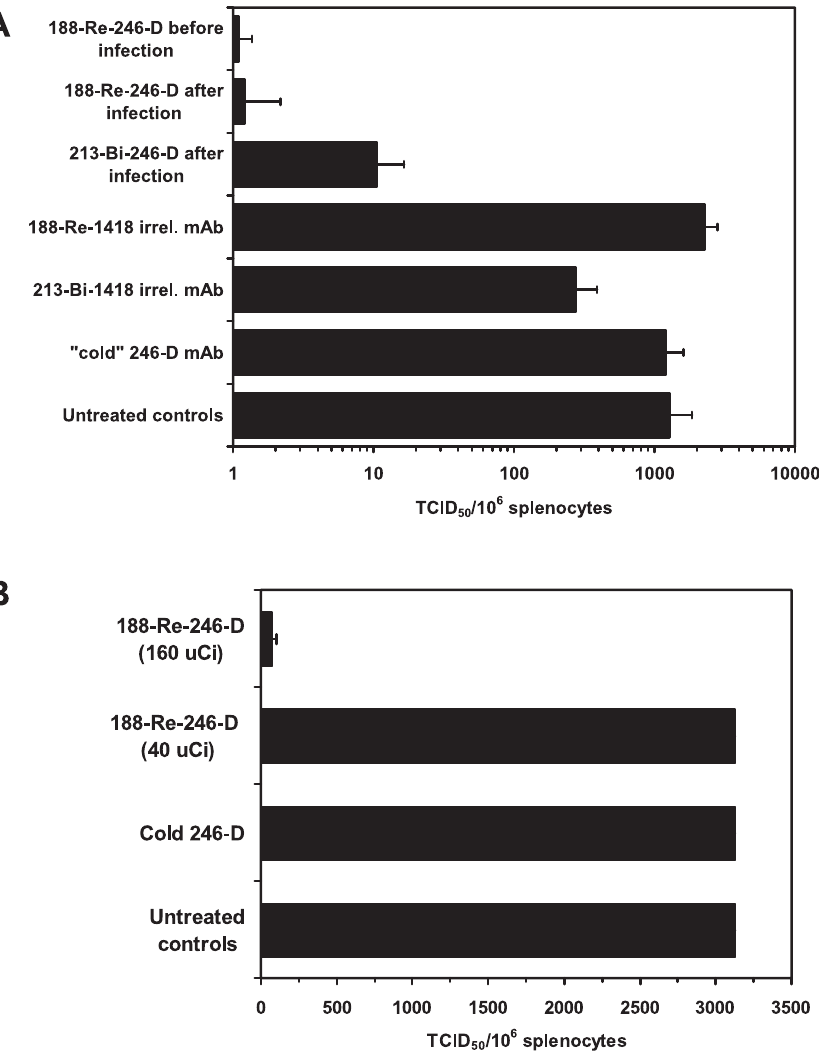
Figure 3. RIT of SCID Mice Injected Intrasplenically with HIV-1 JR-CSF -Infected Human PBMCs with 188 Re- and 213 Bi-Labeled Human Anti-gp41 mAb 246-D (A) Mice were treated IP 1 h after infection with infected hPBMCs with either 20 l g of cold 246-D ( n ¼ 4); 100 l Ci (3.7 MBq) (20 l g) of 213 Bi-1418 ( n ¼ 5) or 80 l Ci (2.96 MBq) (20 l g) of 188 Re-1418 ( n ¼ 3) as isotype-matching controls; 80 l Ci (2.96 MBq) (20 l g) of 188 Re-246-D ( n ¼ 4); or 100 l Ci (3.7 MBq) (20 l g) of 213 Bi-246-D ( n ¼ 5). One group was left untreated ( n ¼ 4). Another group of mice were given 80 l Ci (2.96 MBq) (20 l g) of 188 Re-246-D IP 1 h before infection with infected hPBMCs ( n ¼ 4). (B) Mice were injected IP with 188 Re-246-D (20 l g) with activity of 40 l Ci (1.48 MBq) ( n ¼ 4), with 160 l Ci (5.92 MBq) ( n ¼ 4), or with 20 l g of cold 246-D ( n ¼ 4). A fourth group was untreated ( n ¼ 4). The number of HIV-1-infected hPBMCs in the spleens were then determined by limiting dilution coculture and presented as TCID 50 /10 6 splenocytes. Each bar represents the mean of TCID 50 /10 6 splenocytes in a given group of mice, and error bars show standard error of the